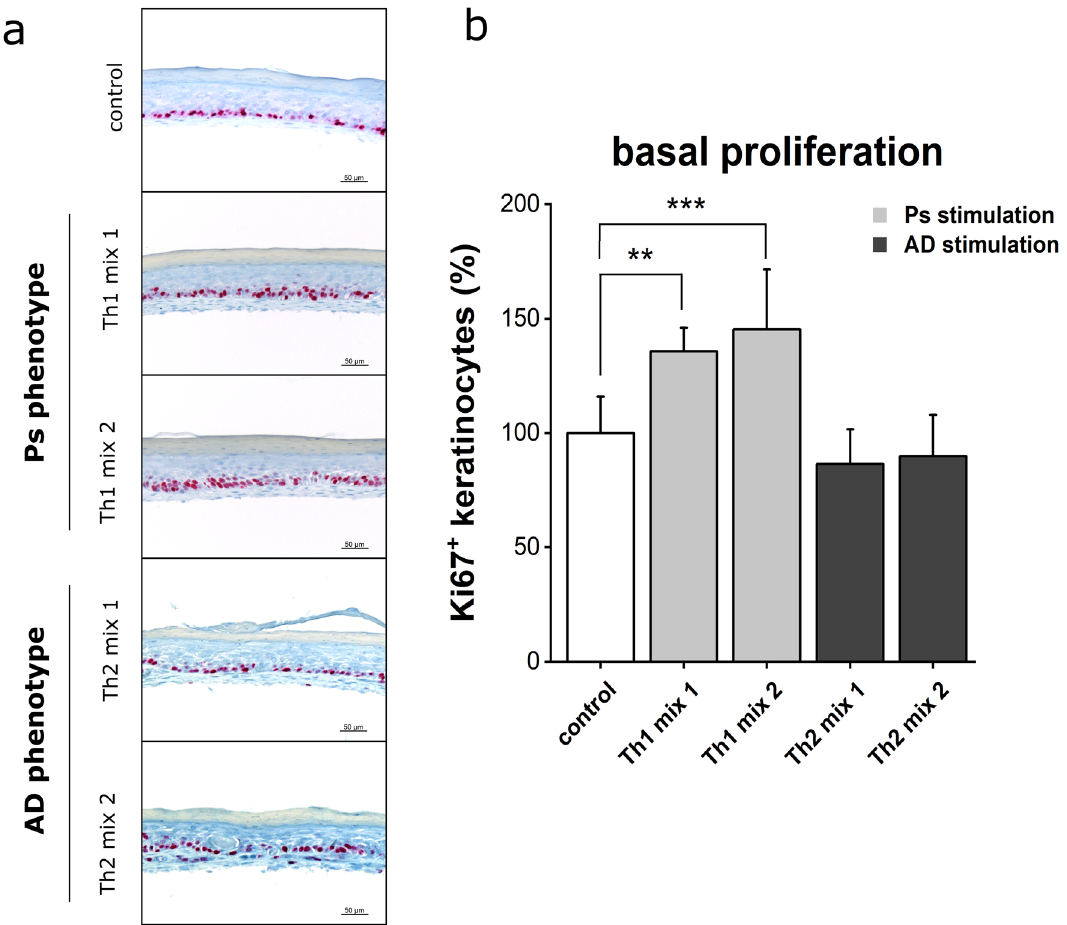
Figure 4. Basal hyperproliferation in psoriasis-like skin models. ( a ) Mitotic cells of skin equivalents (unstimulated physiological control or stimulated with Th1, Th2 cytokine mixes) were visualized using Ki67 immunohistochemistry staining. Scale bar: 50 µm, ( b ) Quantification of Ki67 positive keratinocytes in % to unstimulated control (mean + SD) of n = 2 experiments with a total of 4 skin models (keratinocytes derived from one donor). Statistics: one-way ANOVA with Bonferroni post hoc test; p ≤ 0.05 *, p ≤ 0.01 **, p ≤ 0.001 *** compared to